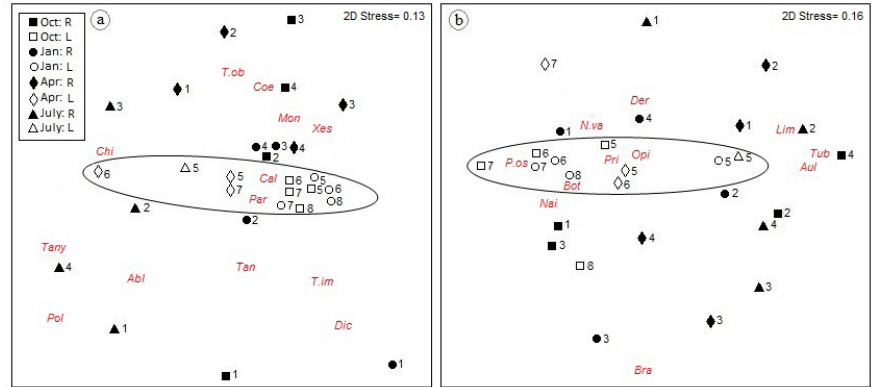
Figure 5. Non-metric multidimensional scaling (NMDS) based on Bray-Curtis similarity for Chironomidae (a) (Cal= Caladomyia , Par= Parachironomus , Tan= Tanytarsus , T.im= Tanytarsus impar , Dic= Dicrotendipes , T.ob= Tanytarsus obiriciae, Coe =Coelotanypus, Mon= Monopelopia, Xes= Xestochironomus, Chi= Chironomus, Tany= Tanypus , Pol= Polypedilum, Abla= Ablabesmyia ) and Oligochaeta; (b) (Bra= Branchiura sowerbyi, P.os = Pristina osborni, Pristina sp., Opi= Opistocysta funiculus, Bot= Bothrioneurum , N.va= Nais variabilis, Nai= Nais communis, Der= Dero ( Aulophorus ) lodeni , Lim= Limnodrilus hoffmeisteri , Aul= Aulodrilus pigueti , Tub= immature Tubificinae) in the Guareí River (R) (1-4) (black symbols) and the lateral area (L) (5-8) (white symbols) in October 2013 and January, April and July 2014.